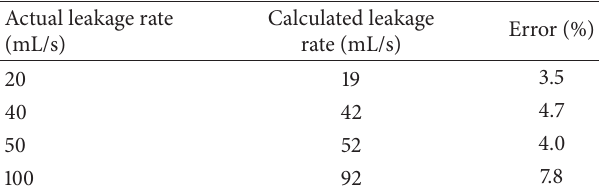
Table 1: Error of measurement of their proposed instrument